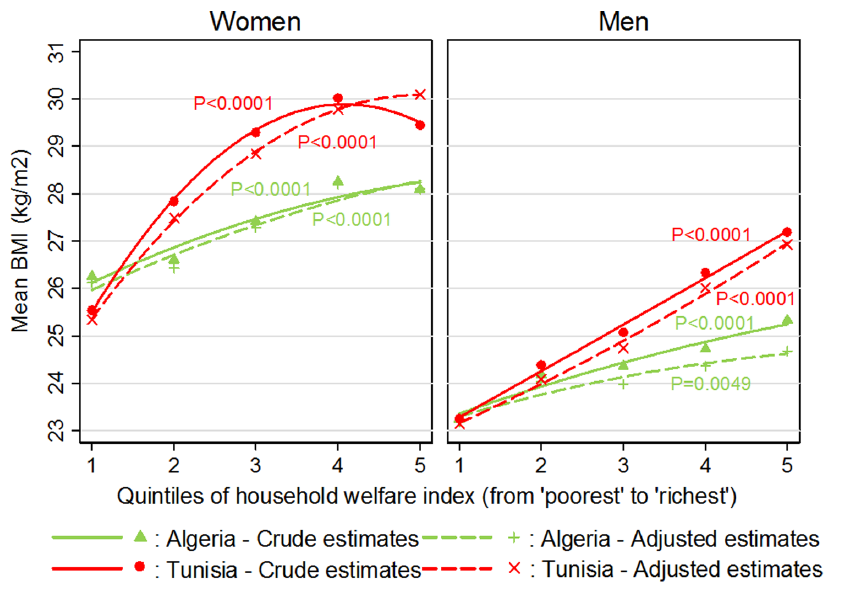
Figure 3. Association between the household welfare index and Body Mass Index among 35–70 year old Algerian and Tunisian adults, by gender. Association between quintiles of the asset-based household welfare index and Body Mass Index among Algerian and Tunisian adults, by gender. Comparison of unadjusted or adjusted (for age, marital status, education, and profession) BMI means by general linear models taking into account sampling design: P-value for null hypothesis of no difference in unadjusted or adjusted BMI means between quintiles of household welfare. Trends interpolated by quadratic fit. Complete case analysis (Algeria women: n=2678, men: n=1944, Tunisia women: n=2725, men: n=2238).